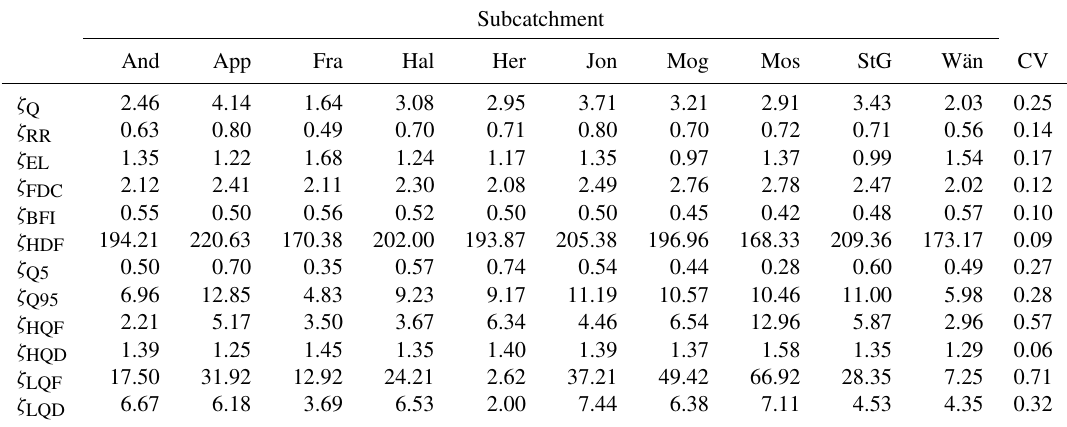
Table 3. Values of the streamflow signatures. The names of the subcatchments are abbreviated using the first three letters and the symbols are reported in Table 2. The last column contains the coefficient of variation of each